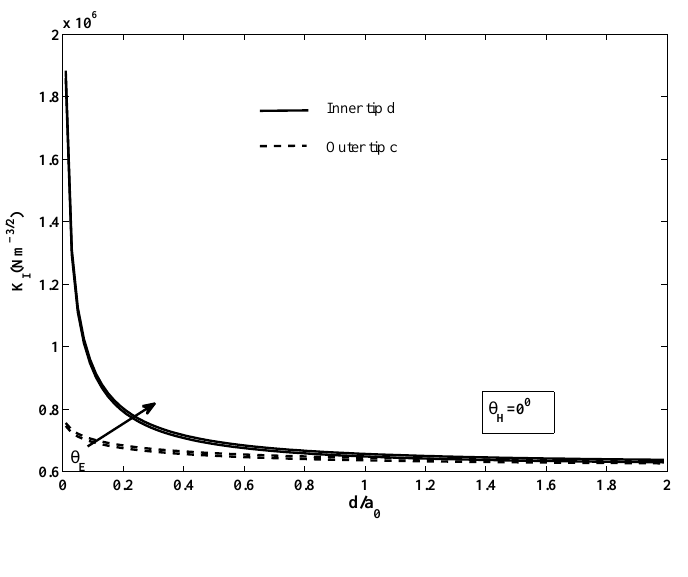
Fig. 2 SIF versus inter-crack distance for different electric poling with fixed magnetic poling